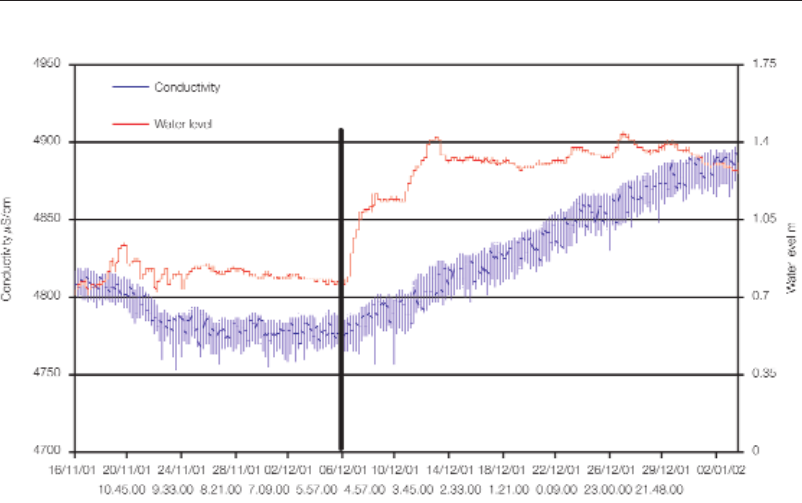
Fig. 10. Temporal variations of conductivity and water level at the Puzzola spring recorded during November 2001-January 2002.The vertical black line marks the M d = 3.1 seismic event that occurred on December 6, 2001.